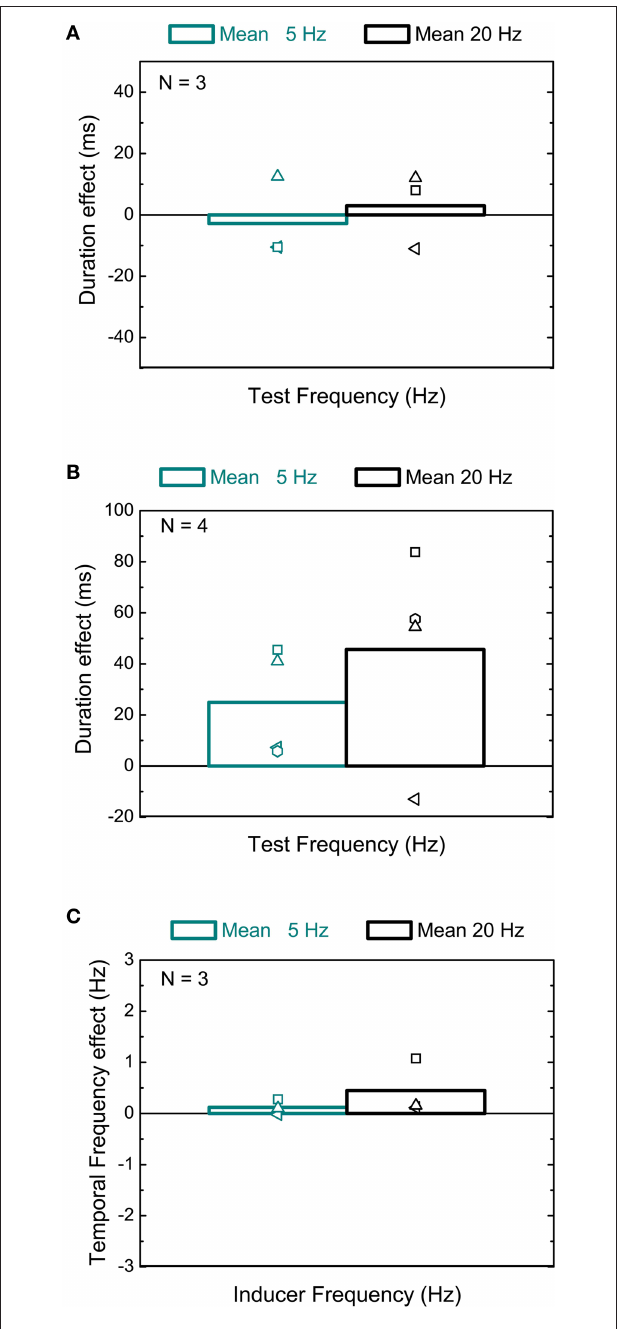
Figure 2 | effects of static contrast context and direct comparison on perceived duration and of luminance contrast on perceived speed. (A) Effects of static contrast context. The differences in perceived duration between the high and low contrast context are plotted against the drift frequency of the test patterns (5 Hz, dark cyan column; 20 Hz, black column) averaged across three different subjects. Empty symbols indicate individual data. (B) Mean duration judgments of a high contrast (90%) compared to a low contrast (10%) interval embedded in a 50% contrast context at 5 (dark cyan column) and 20 Hz (black column). (c) Results for the perceived speed experiment averaged across three different subjects. Dark cyan column indicates the difference in apparent speed between the two contrast contexts at 5 Hz, while black column indicates the same difference at 20